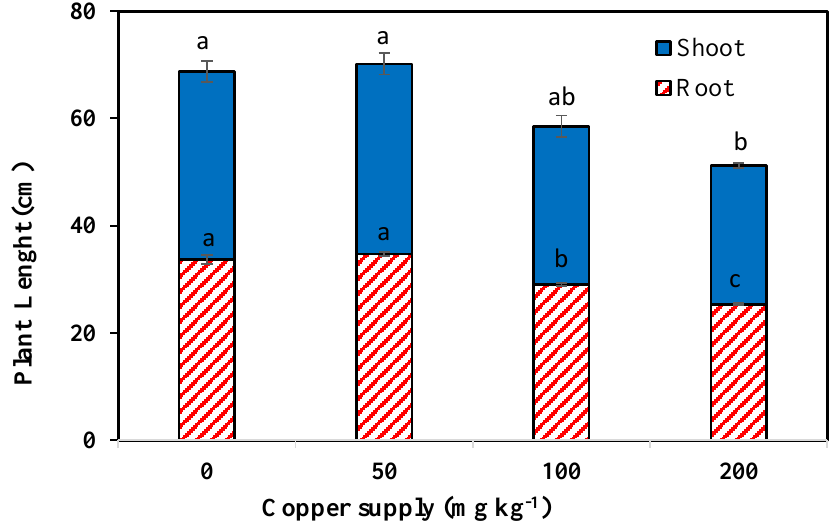
Figure 3. The length of Zea mays grown in contaminated soil with soil with 0, 50, 100 and 200 mg kg − 1 copper after 42 days. Mean values that do not share a letter are significantly different at p = 0.05 (mean ± S.E.; n = 3).